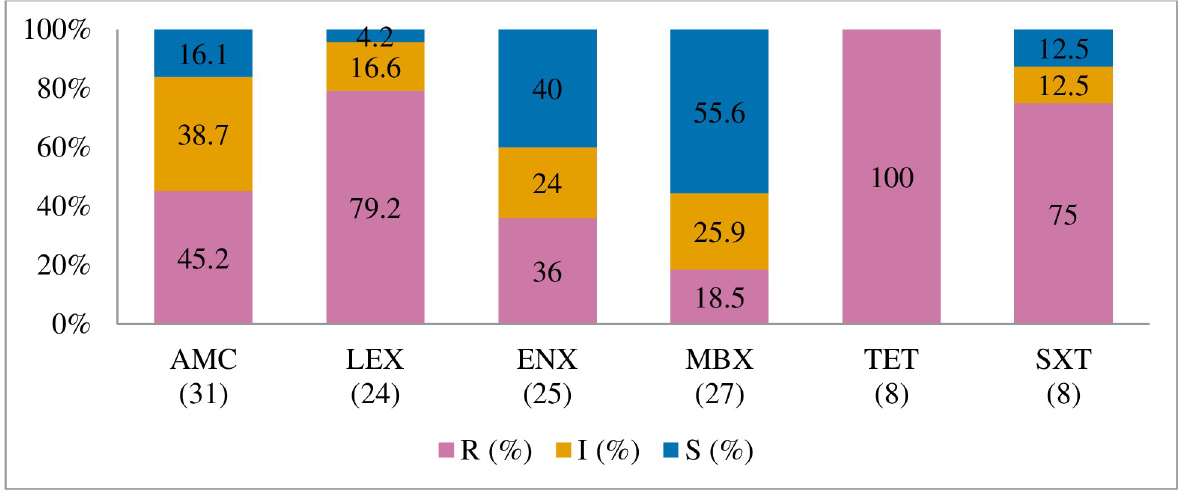
Fig 9. Antibiotic susceptibility pattern from Proteus mirabilis isolates from diseased dogs (January 2015-December 2017). R–resistance; I- intermediate; S–susceptible; AMC–amoxicillin/clavulanic acid; LEX–cephalexin; ENX–enrofloxacin; MBX–marbofloxacin; TET–tetracycline; SXT– trimethoprim-sulfamethoxazole. Numbers inside brackets ‘()’ indicate the total number of tested isolates for each antibiotic.